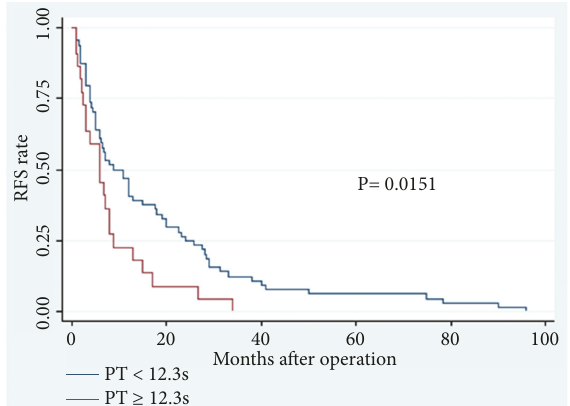
Figure 2: Recurrence-free survival in patients with cholangiocarci- nomaaccordingtoPTlevels(P=0.0151)(PT,prothrombintime;RFS, recurrence-free